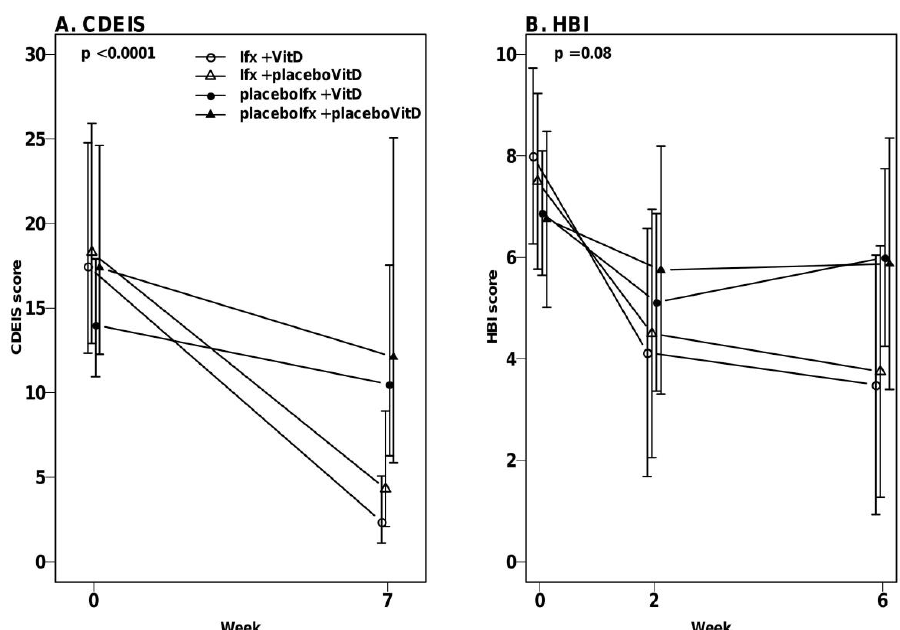
Figure 2. Changes in endoscopic and clinical disease activity. Crohn’s Disease Endoscopic Index of Severity (CDEIS) and Harvey-Bradshaw Index (HBI) scores during the active vitamin D treatment. Dots represent medians with 95% CI. ( A ). CDEIS scores at weeks 0 and 7 (“week 7” includes week 3 rescue colonoscopy) within the four groups. Vitamin D treatment did not affect changes in CDEIS score in neither the Ifx + VitD versus Ifx + placeboVitD groups nor in the placeboIfx + VitD versus placeboIfx + placeboVitD groups. The CDEIS score of both infliximab groups declined significantly compared to the placeboIfx + VitD and placeboIfx + placeboVitD group ( p < 0.02). ( B ). HBI scores at weeks 0, 2 and 6 (week 6 includes rescue week 3 HBI scores). HBI changes were not influenced by vitamin D treatment in either the Ifx + VitD versus Ifx + placeboVitD groups or in the placeboIfx + VitD versus placeboIfx + placeboVitD groups. Similar to the CDEIS scores, the HBI scores of the two infliximab groups declined in comparison to the placeboIfx + VitD ( p < 0.03) and placeboIfx + placeboVitD groups ( p = 0.05). VitD, vitamin D; Ifx,